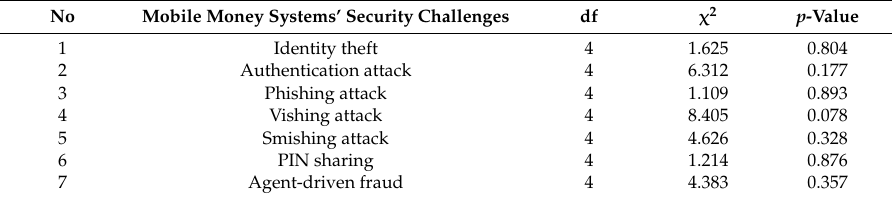
Table 5. Relationship between gender and mobile money systems’ security